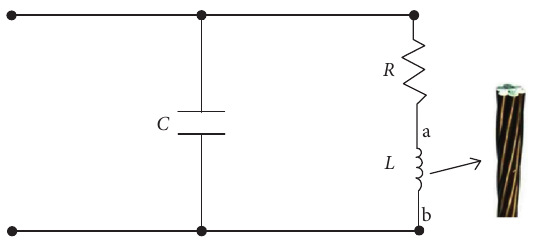
Figure 1: LC oscillation circuit